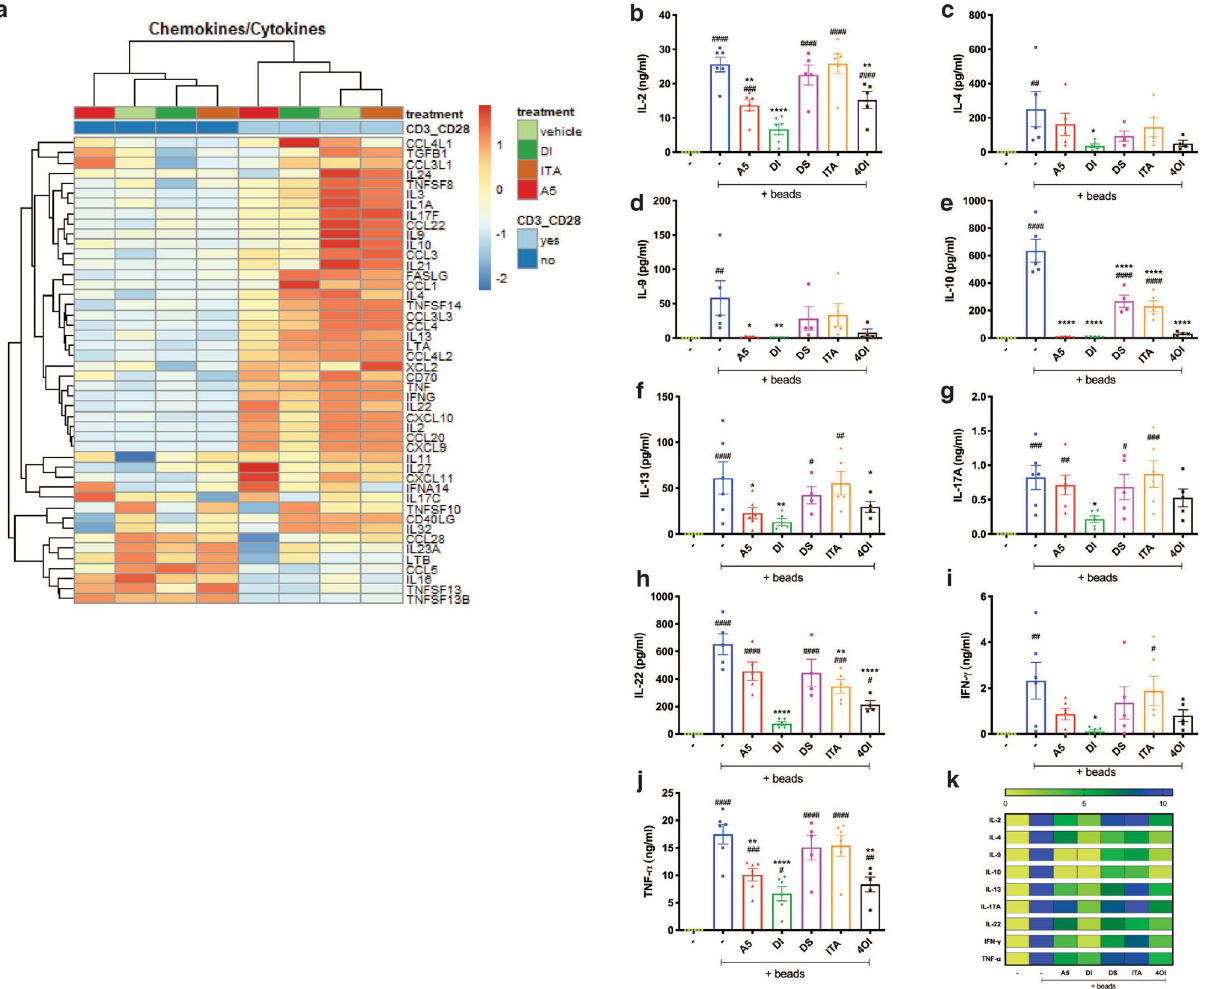
Figure 4. SDH activity is essential for T cells cytokine production. ( a ) Heat map with Z-score of cytokines- and chemokines-related genes from Affimetrix gene expression array performed on (pooled RNA from n = 3 independent experiments) resting and beads-activated CD4 + T cells exposed to A5 (20 μM), DI (250 μM), or ITA (1 mM). ( b – j ) Secreted cytokines by CD4 + T cells after 24 h activation and drug-treatment (n = 4–6 independent experiments, with n = 2 technical replicates) measured by MSD and ELISA. All charts show mean and ± s.e.m. ( k ) Concentration of cytokines were normalized to each activated untreated control and are displayed in a color-scaled heat-map. P values are calculated using one-way ANOVA test followed by Dunnet’s test to different control groups: (#) to the unstimulated and untreated control, and (*) to the activated untreated control. # or *P < 0.05, ## or **P < 0.01, ### or ***P < 0.001, #### or ****P < SDH activity is essential for T cell cytokine production. In order to investigate whether SDH inhibi- tion would compromise cytokine and chemokine expression, we exposed purified CD4 + T cells to A5, ITA or DI, for 24 h during the early activation. As expected, activation of CD4 + T cells induced expression of a wide range of cytokines and chemokines (Fig. 4a). The analysis revealed that none of the compounds altered the expression of cytokine and chemokine genes in unstimulated cells. In contrast, expression of many of the induced cytokines and chemokines in activated cells was modulated (Fig. 4a). In details, the data showed a strong immunomodu- latory capacity mediated by A5, and DI, compared to vehicle and ITA-treated samples (Fig. 4a). The effect on expression of the important inflammation mediators IFNG and TNFA were additionally assayed by qPCR, and the analysis confirmed that A5 and DI strongly inhibit the expression of both, while 4OI only affected expression of IFNG, ITA had no effect on expression of either gene (Fig. S4a,b). To evaluate the importance of SDH fitness on CD4 + T cell functionality, we next measured production of selected cytokines by ELISA and MSD. This time we also used ITA and its derivatives to explore their effect upon cytokine production by T cells. The analysis revealed that DI potently inhibited secretion of all targeted cytokines (Fig. 4b–j). In contrast, A5 only significantly inhibited IL-2, IL-9, IL-10, IL-13, TNF-α (Fig. 4b,d–f,j). In addition, although not significant, we also observed a tendency of A5-mediated reduction of IL-22 and IFN-γ secretion (Fig. 4h,i), whereas no effect was observed on IL-4 and IL-17A (Fig. 4c,g). Whether this effect was exclusively mediated by the increase of the intracellular succinic acid was unclear, as exogenous supplementation